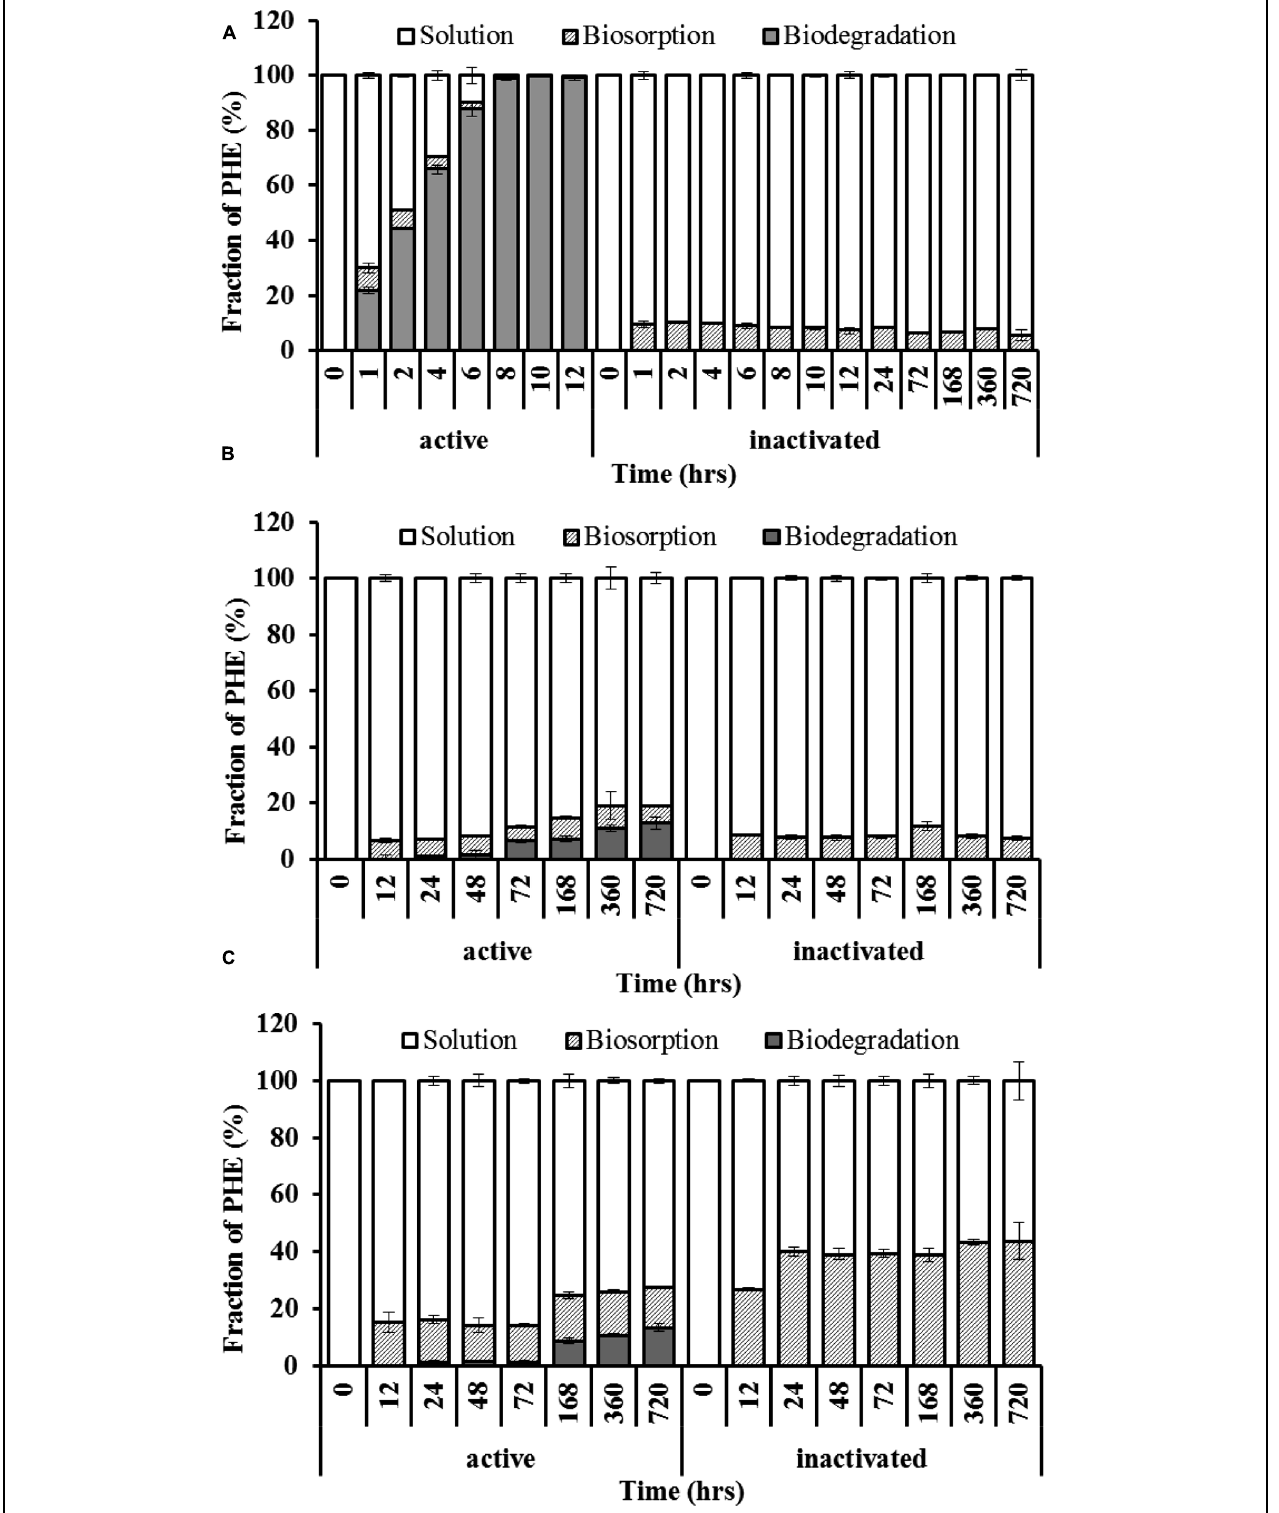
FIGURE 2 | Spatiotemporal distribution of PHE in liquid cultures with Massilia sp. WF1 (A), spore (B), and mycelial pellet (C) of Phanerochaete chrysosporium at 28 ◦ C. Bars are ± standard deviation of five analyses.